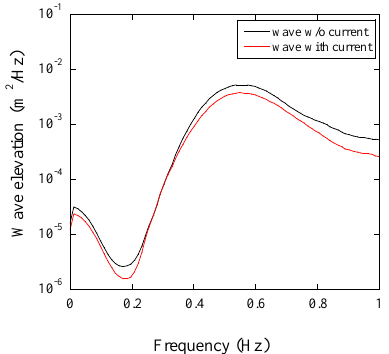
Figure 13. PSD of measured wave elevation.